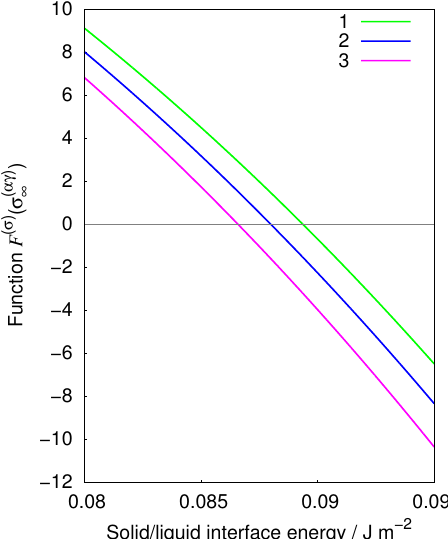
Figure 2. Function F (σ) in dependence of the solution/solute inter- facial energy σ (αγ) ∞ according to Eq. (7) for three different ERH values ERH = ERH 0 + (cid:49) ERH with ERH 0 denoting the nominal value of ERH according to the power law fit given by Eq. (9) with (cid:49) ERH optionally assuming − 1%rh, 0%rh, and + 1%rh, corre- sponding to graphs 1, 2, and 3 respectively. The sought-after value σ (αγ) ∞ is the abscissa value corresponding to the functional value F (σ) (σ (αγ) ∞ ) = 0, indicated by the solid horizontal